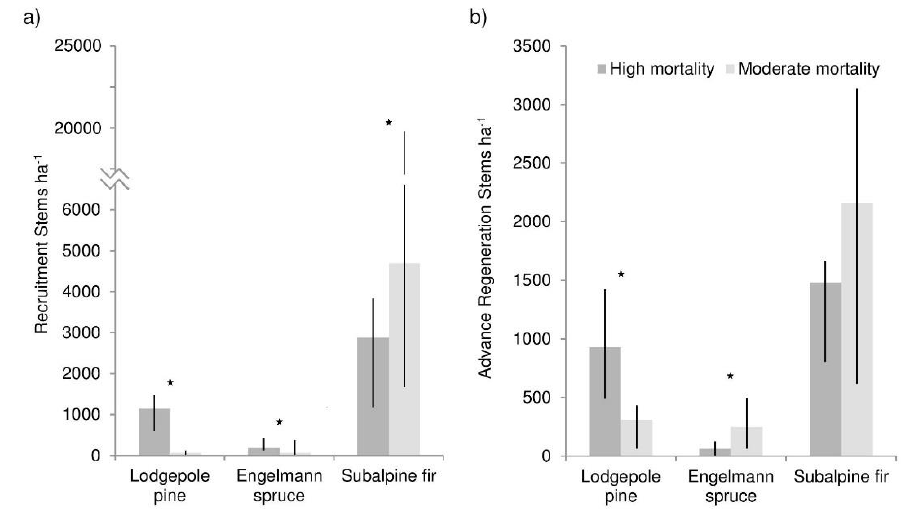
Figure 2. Median density of lodgepole pine, Engelmann spruce, and subalpine fir ( a ) recruitment (trees with less than 8 bud scars and <1.4 m tall) and ( b ) advance regeneration (trees with 8 or greater bud scars and <1.4 m tall) in high and moderate overstory mortality areas. Stars indicate a significant difference between the two mortality levels (α = 0.05). Lines show the 25th and 75th percentile densities.